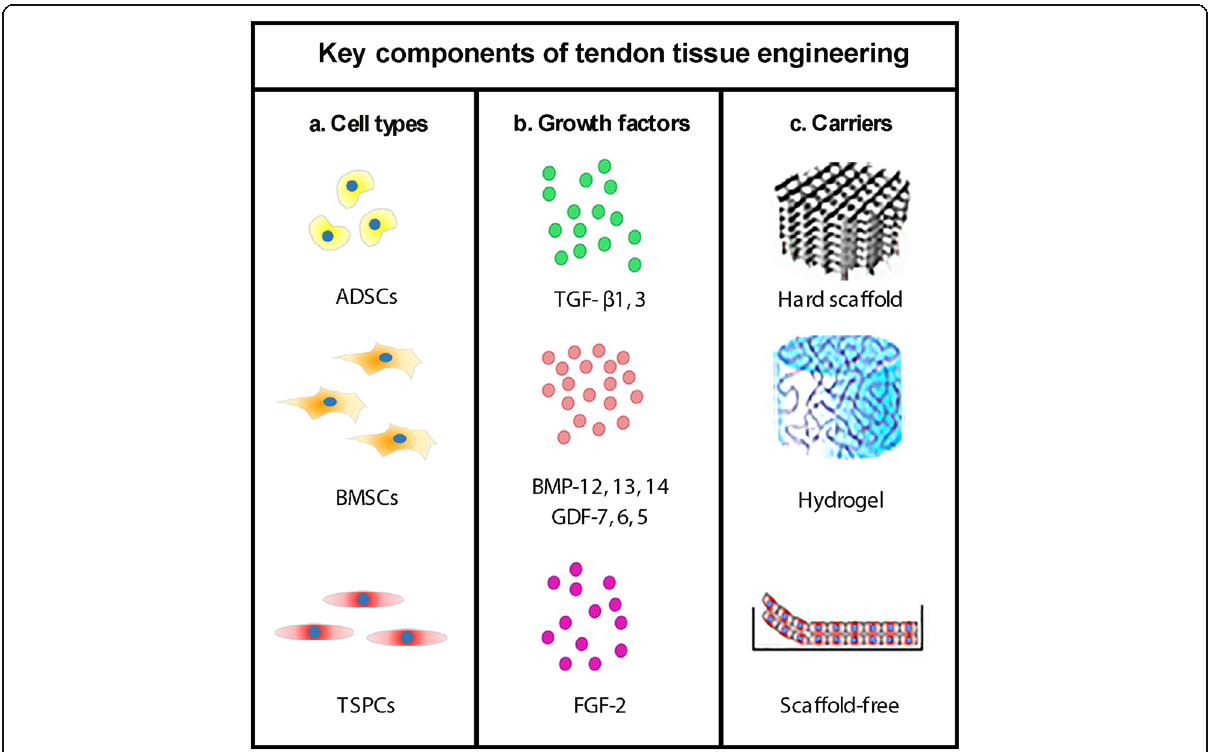
Fig. 1 Summary of the key components of tendon tissue engineering. a Favourable cell types; b Pro-tenogenic growth factors; c Possible scaffolds and self-assembled materials. Various combinations between the components are